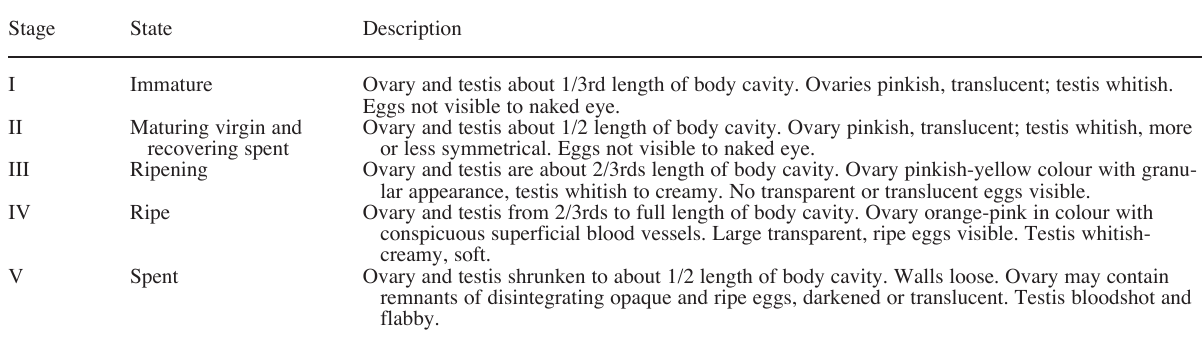
(Table 1) in Civitavecchia harbour during under- water works for constructing a new quay that required using explosives. Due to these explosions, the individuals caught were already dead and float- ing on the